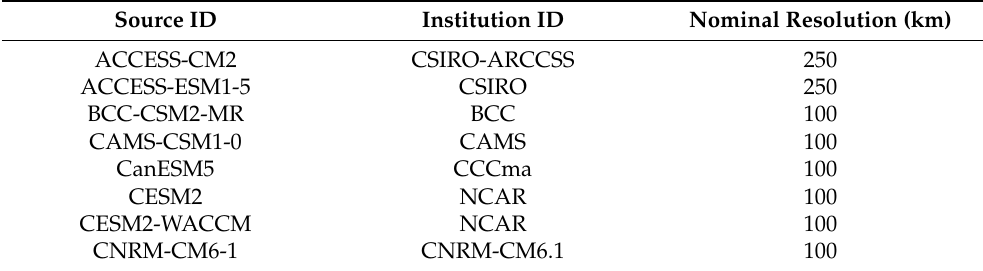
Table A1. Information about the Coupled Model Intercomparison Project Phase 6 (CMIP6)